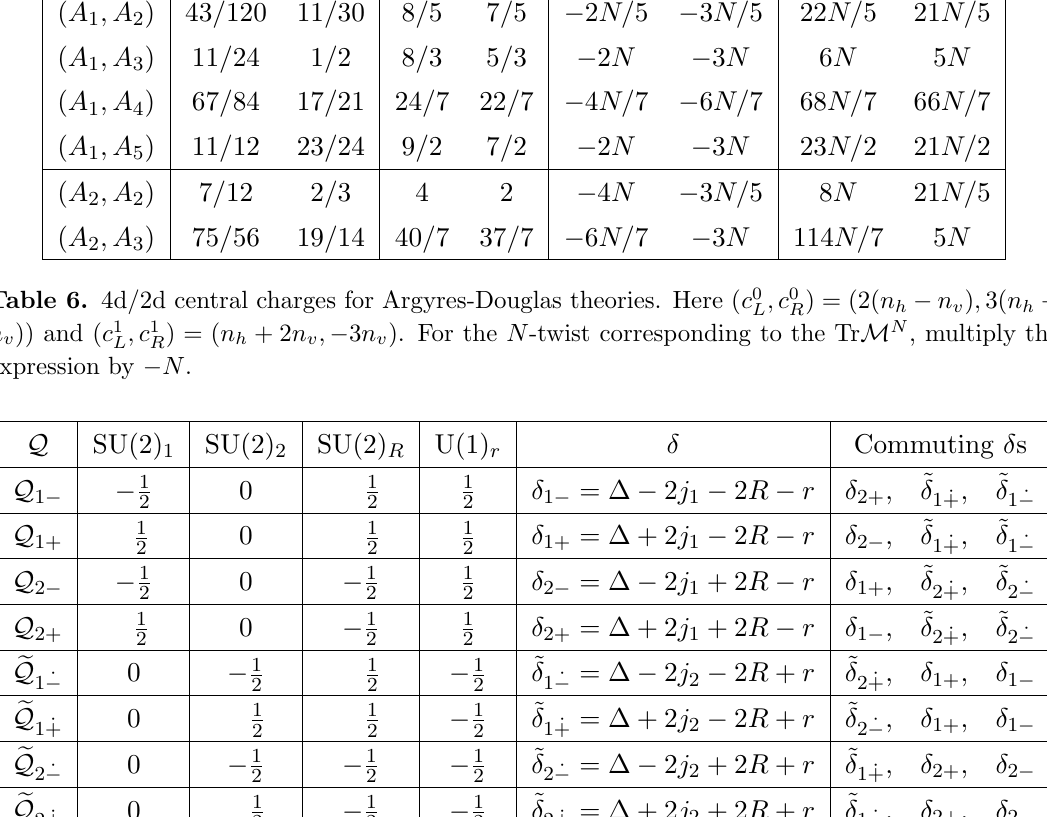
Table 7. For each supercharge Q , we list its quantum numbers, the associated (cid:14) (cid:17) 2 the other (cid:14) s commuting with it. Here I = 1 ; 2 are SU(2) R indices and (cid:11) = (cid:6) , _ (cid:11) = (cid:6) Lorentz indices. (cid:1) is the conformal dimension, ( j 1 ; j 2 ) the Cartan generators of the SU(2) 1 (cid:10) SU(2) 2 isometry group, and ( R ; r ), the Cartan generators of the SU(2) R (cid:10) U(1) r R-symmetry group.